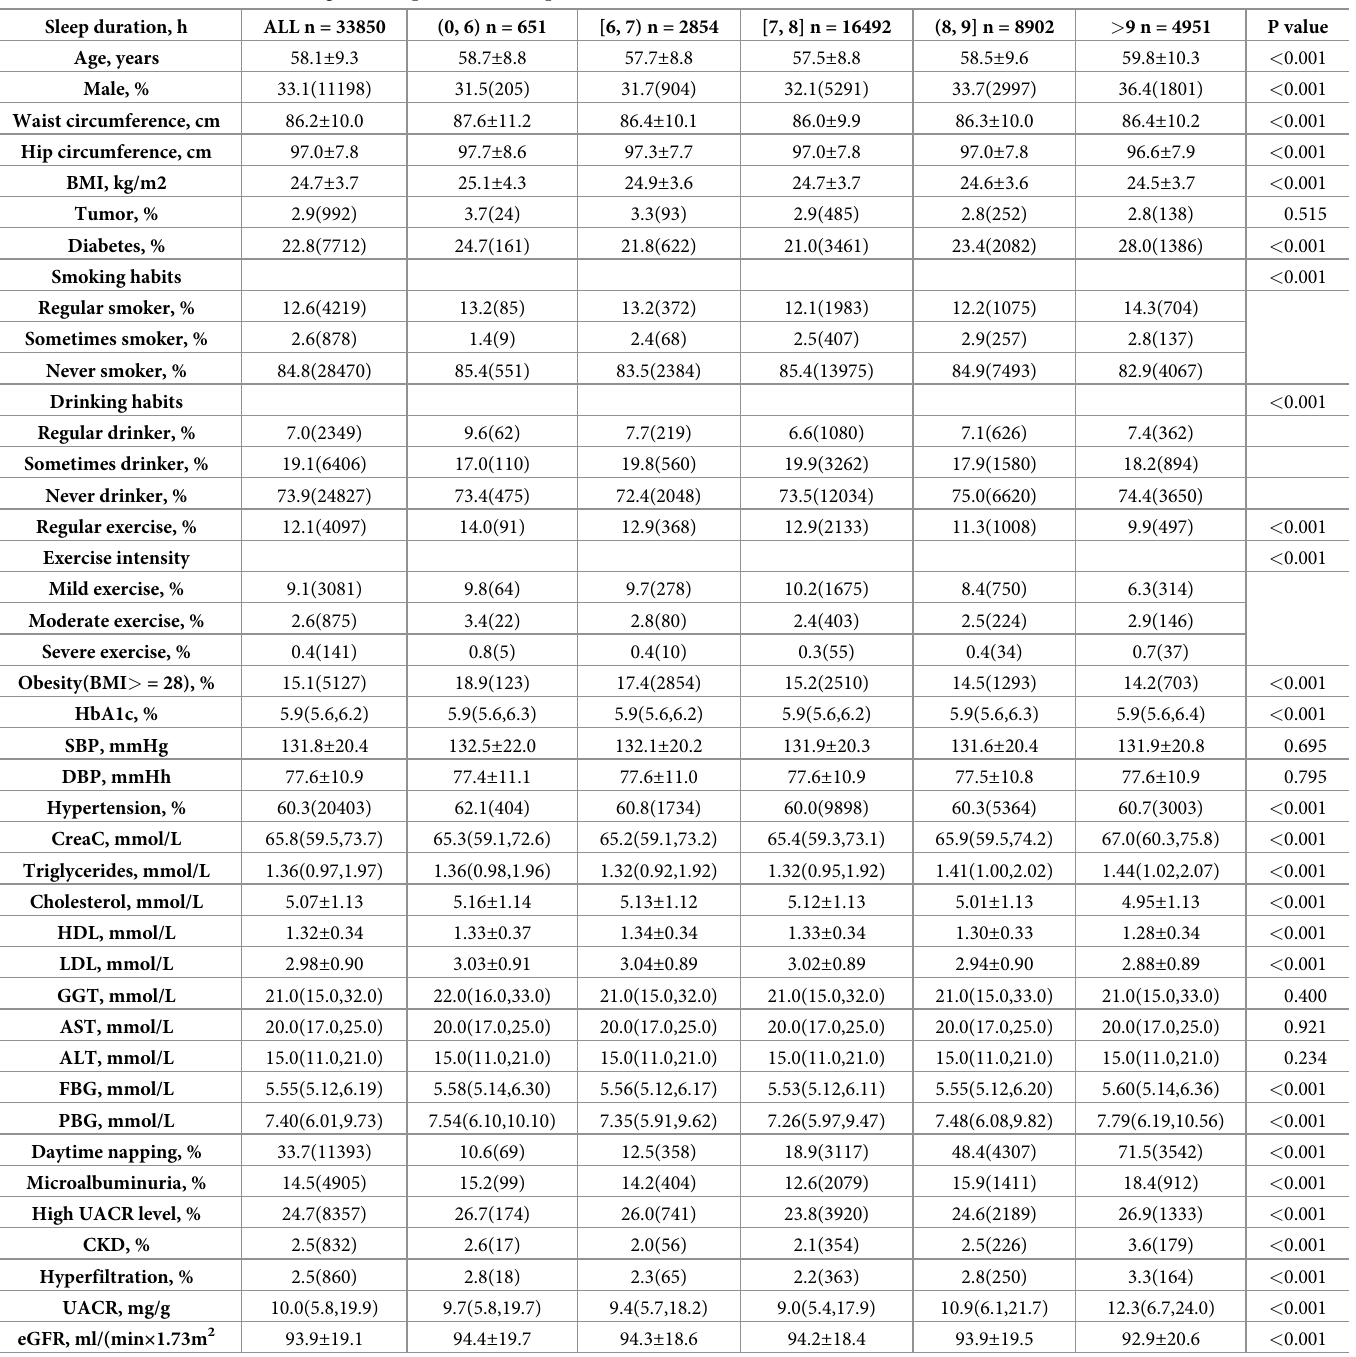
Table 1. Baseline information according to self-reported total sleep